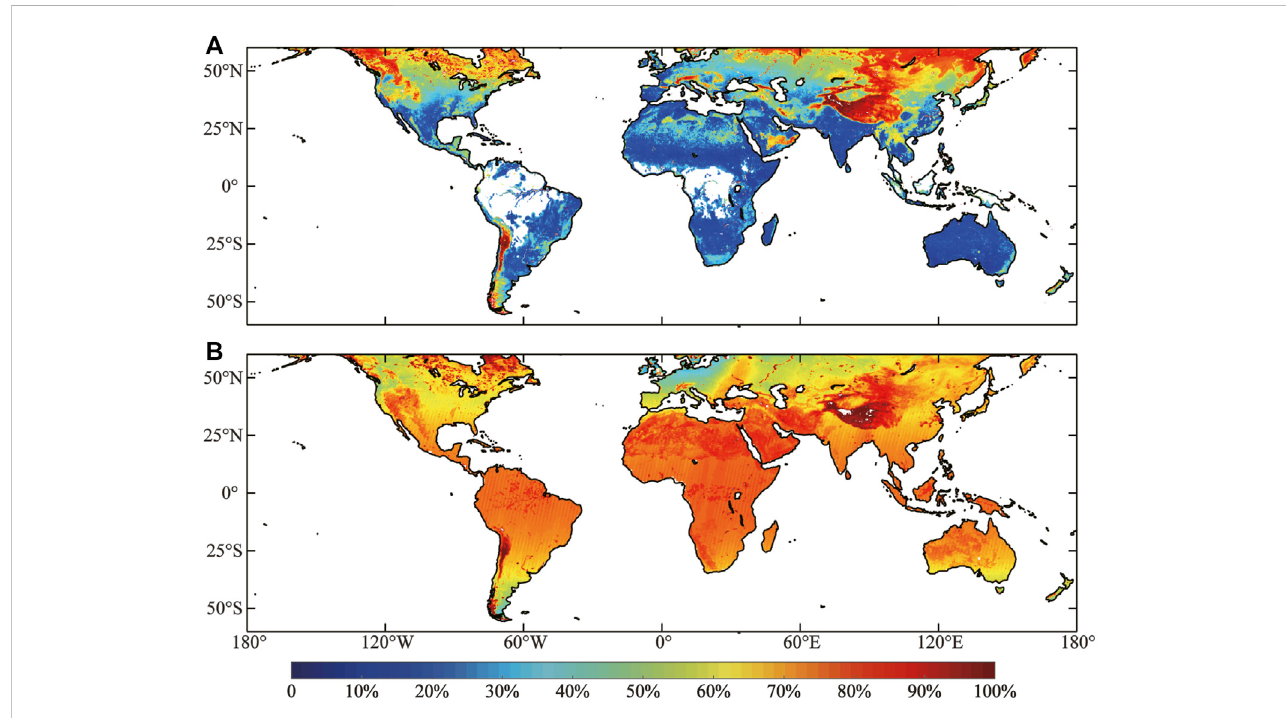
FIGURE 1 Percentages of missing values in (A) CCI ori data during 1989 – 2021, and (B) CM ori data during 2006 – 2019.